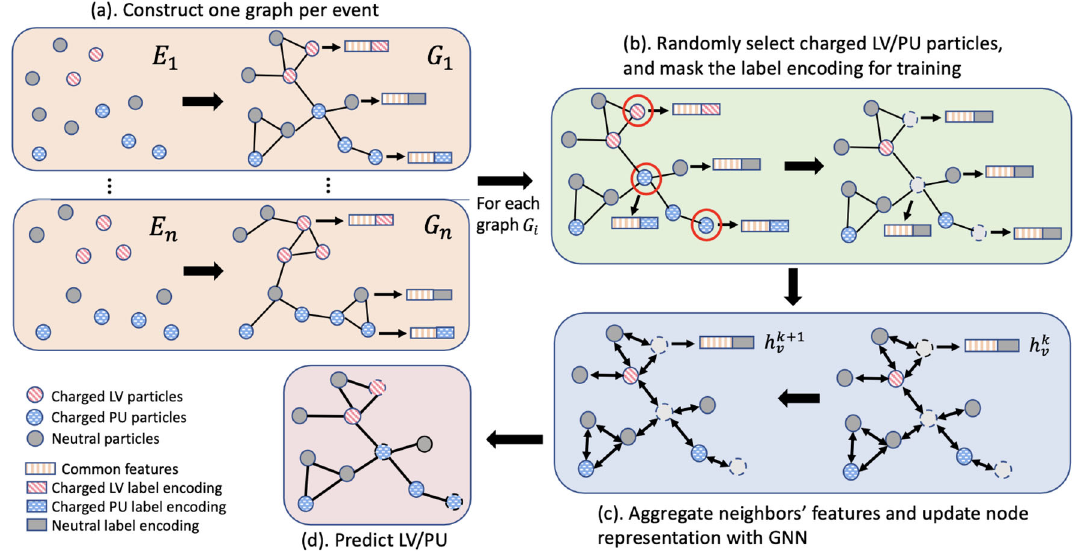
Fig. 1 A diagram illustrating the SSL model training